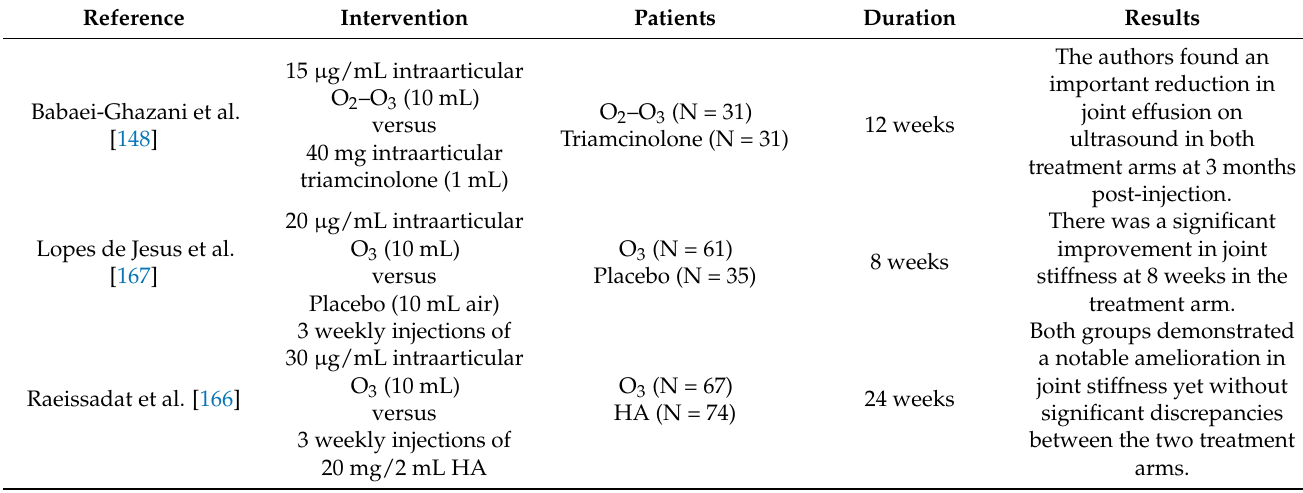
Table 4. O 3 and O 2 –O 3 treatment in knee OA: anti-inflammatory